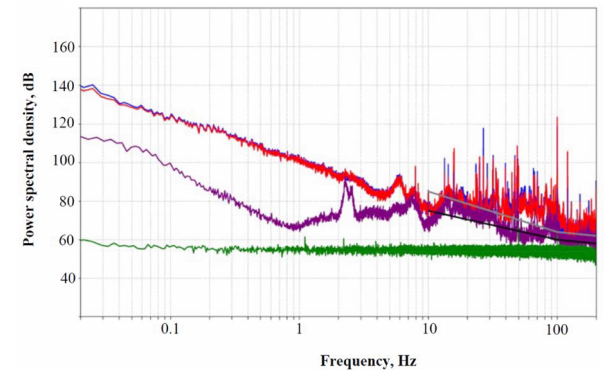
Figure 12. METH closed-loop feedback self-test calibration (blue curve) with BC-311 sensitivity level (red curve). Hz – on the x axis; mVPa − 1 – on the y axis.